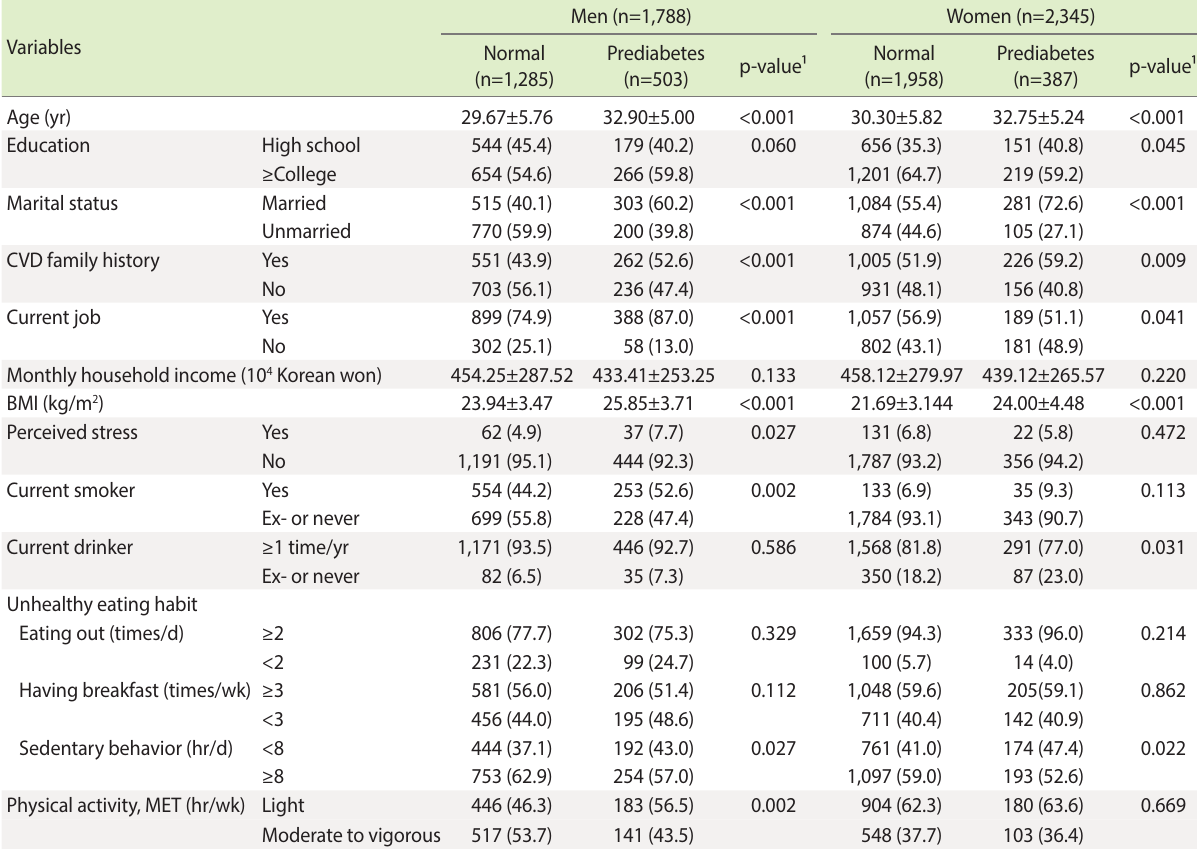
Table 3. Differences in subject characteristics and lifestyle variables between normal and prediabetic groups